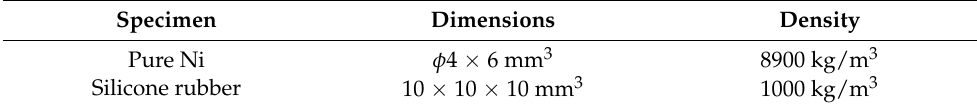
Table 2. The dimensions and density of the Ni and silicone rubber.